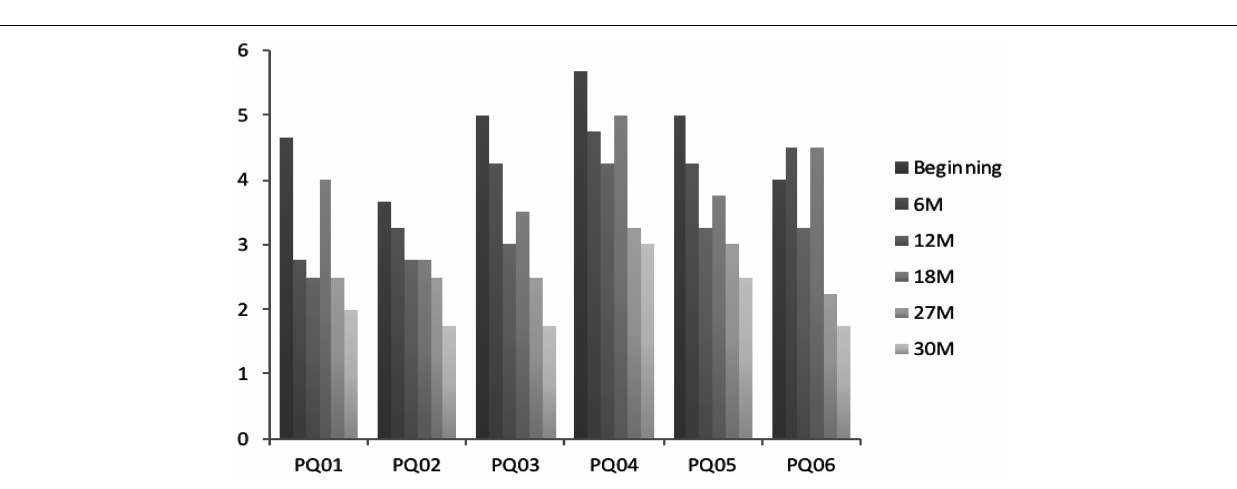
FIGURE 6 | John’s means (four sessions) of PQ items values over time. M, months in